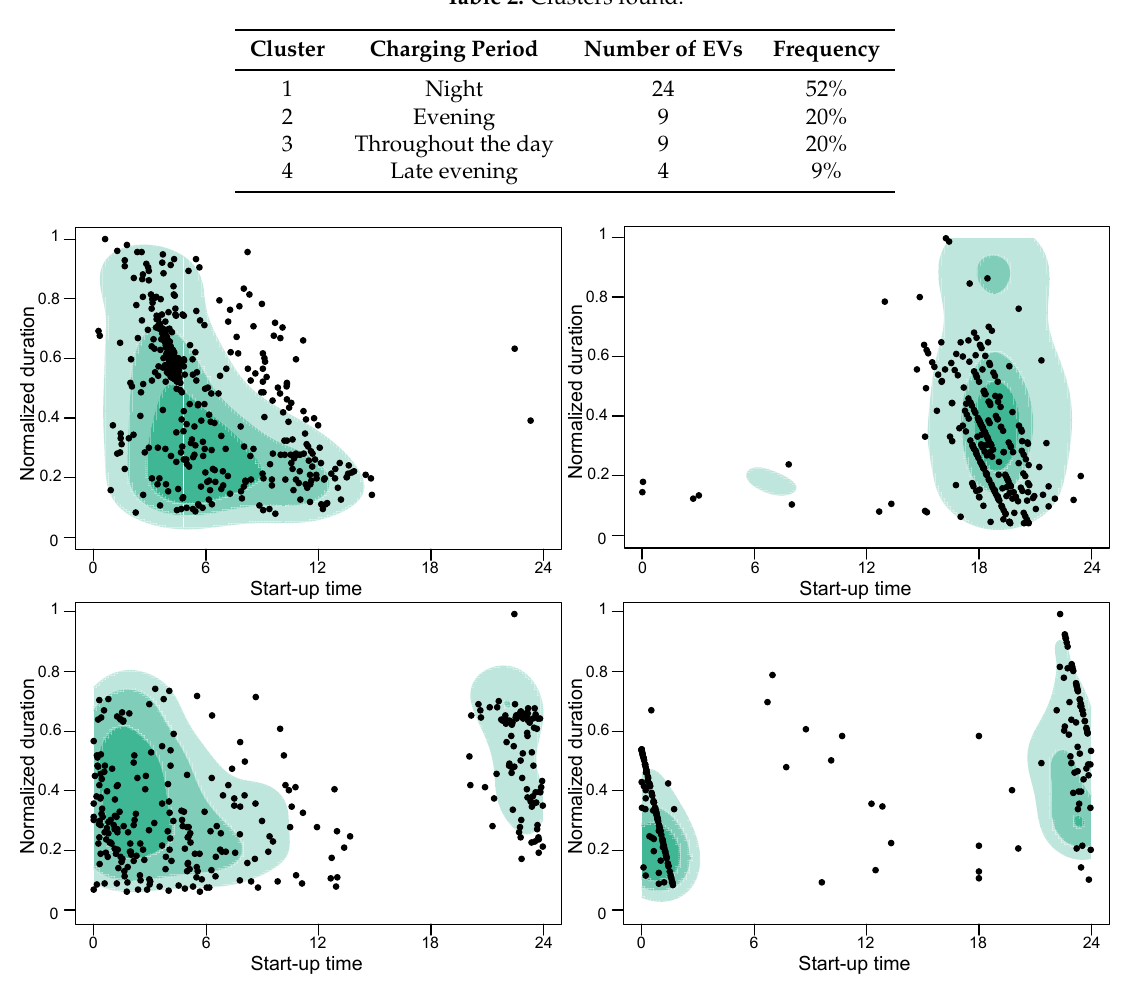
Figure 5. Representation of the charging patterns for the four clusters: the two dimensional density function is estimated with all the EVs of a cluster (green filled contours) and the points represent the charging block a specific EV in the cluster. On the y -axis is the normalized duration, i.e., the charging duration normalized by maximal duration observed for this EV. On the x -axis is the hour of the